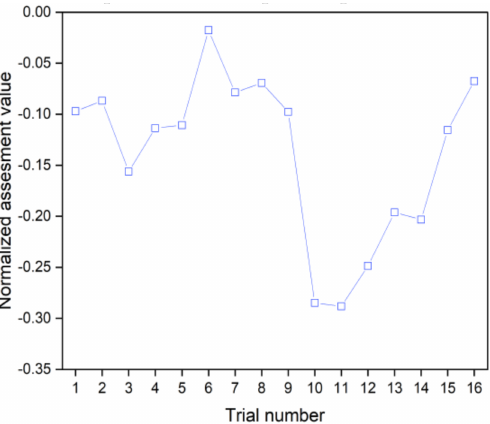
Figure 8. Normalized assessment values in MOORA method for case study 1. The rankings of the alternative trials derived using the four MCDM techniques are compared in Figure 9.